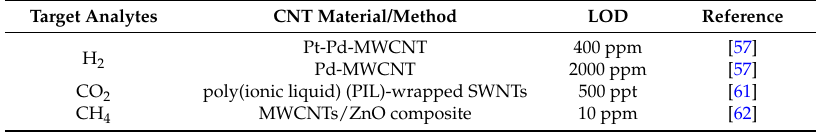
Table 2. Summary of sensing performance of H 2 /CO 2 /CH 4 chemiresisitive